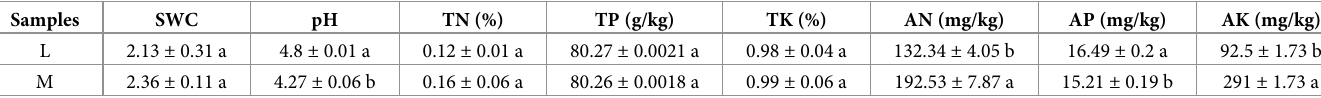
Table 2. Soil physicochemical properties between moss- (M) and non-moss growth (L) areas in litchi orchard. Samples